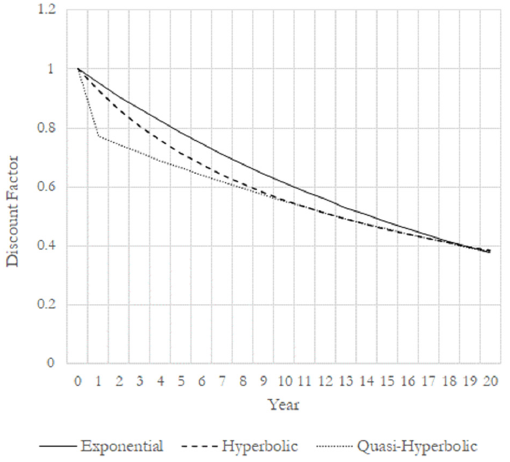
Figure 7. A hypothetical discount function, derived from [14,19], illustrating exponential discounting ( 𝑖 (cid:3006) = 0.05 ), hyperbolic discounting ( 𝑖 (cid:3009) = 0.08 ), and quasi-hyperbolic discounting ( 𝛽 = 0.08, 𝑖 (cid:3018)(cid:3009) = 0.038,𝛾 = 0.9634) . ( β = 0.08, i = 0.038, γ = QH